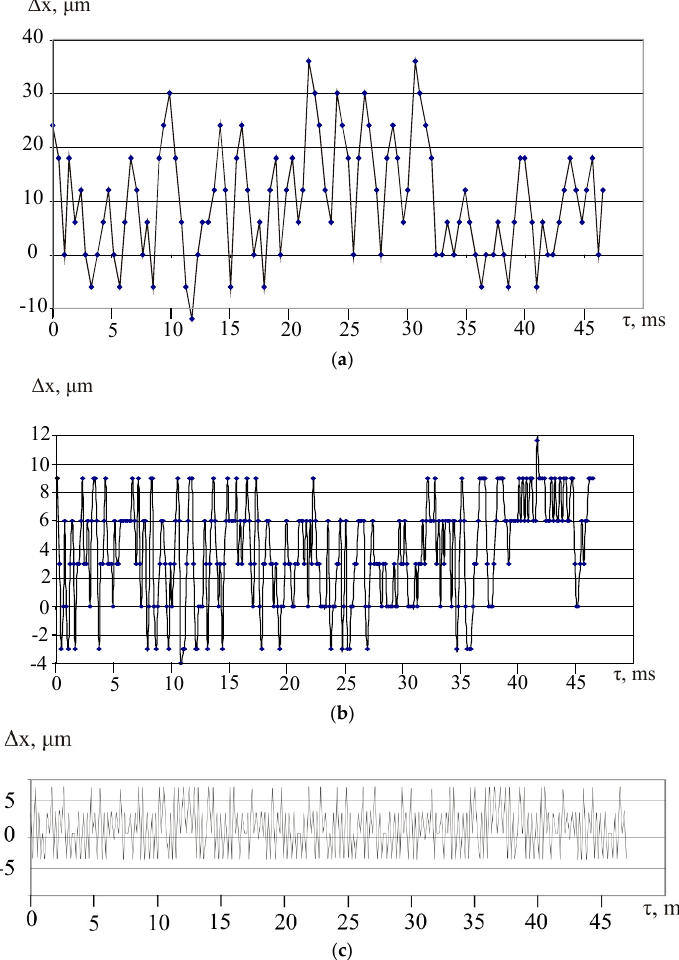
Figure 5. Dynamics of movement of the deforming element with a pressing force: ( a )-5 N, ( b )-55 N, ( c )-105 N ( Δ x-range (doubled amplitude) of oscillations, τ -time). At various pressing forces, the nature of the movement of the deforming body (ball) is quasi-periodic. An analysis of film frames shows that with a force of 5 N, the impact frequency is approximately 550 Hz, and the range (doubled amplitude) of oscillations is 20 ... 30 µm. With an increase in the pressing force to 55 N, the impact frequency increases to 1400 Hz, and the range is 9 ... 12 µm. At the pressing force 105 N, the impact frequency increases to 6000 Hz, and the range is 6 ... 9 µm. The obtained data on the change in the roughness parameters at different pressing forces of the deforming element to the treated surface are shown in Figure 6.